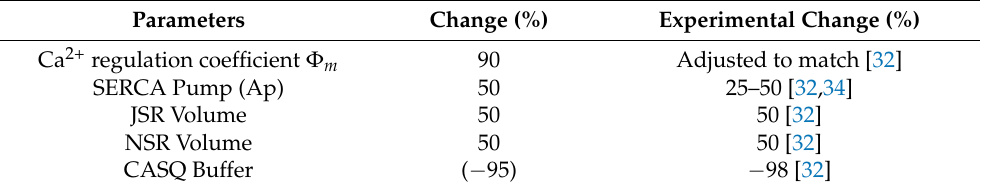
Table 1. Simulation parameters for β -adrenergic stimulation in WT and mutant myocyte This is a